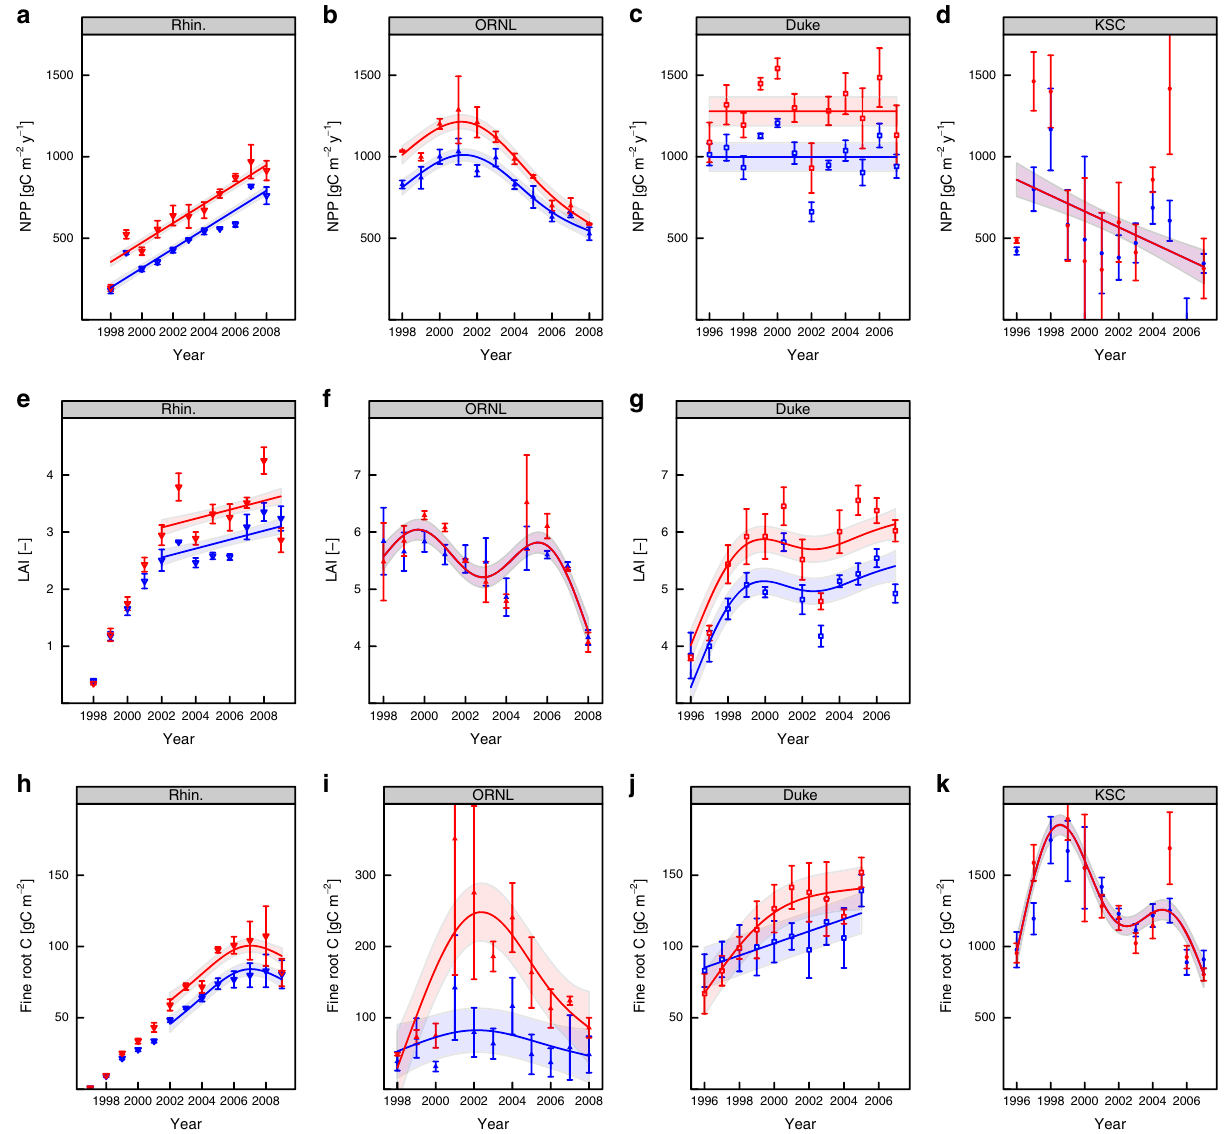
Fig. 1 Trends in ecosystem variables to indicate successional stage. Annual net primary production (NPP; a – d ), peak leaf area index (LAI; e – g ) and fi ne-root biomass ( h – k ) dynamics over the duration of the experiments. Data show treatment (ambient shown in blue and elevated in red) means ± SEM (standard error of the mean) in each year, lines and shaded areas show the best generalised additive mixed model (GAMM) or linear models selected using corrected Akaike Information Criterion (AICc) from a set of candidate models. The number of knots in the GAMMs were determined using half the number of years in the data either minus one for even numbers of years or rounded down to the nearest integer for odd numbers (constrained to a minimum of four knots). This knot speci fi cation was intended for multi-annual trend detection that avoided over-sensitivity to inter-annual